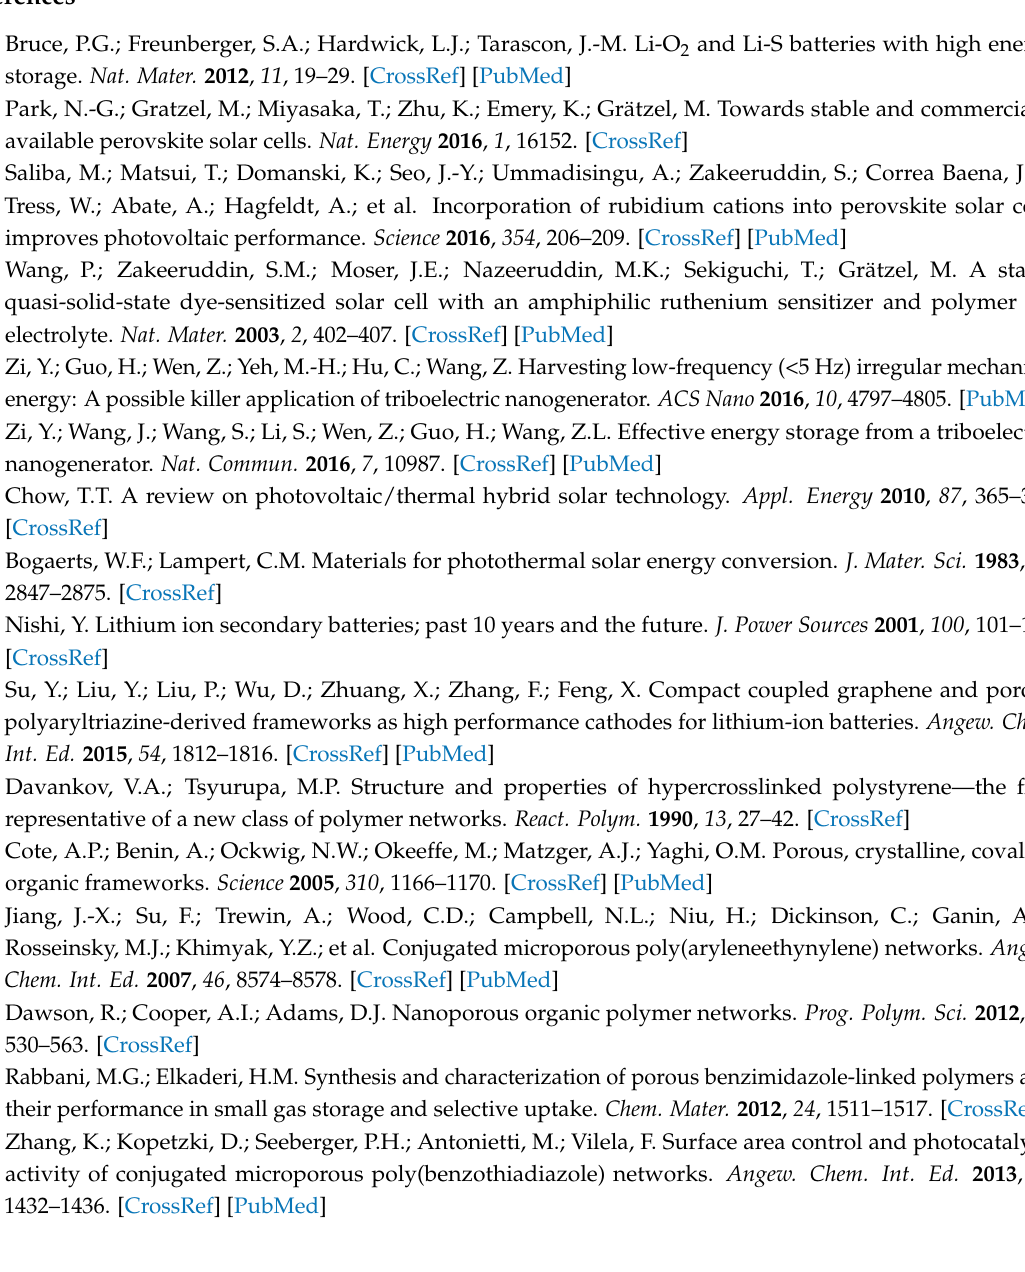
Figure S1. A schematic showing the structure and formation process of CTF-1; Figure S2: XRD patterns of CTF composites with different carbon materials. (a) CTF-CS, (b) CTF-CNT; and (c) CTF-GA; Figure S3. Pore size distribution of CTF and different CTF composites calculated from QSDFT; Figure S4: An SEM image of GA showing the macroporous nature; Figure S5: The FT-IR spectra and XRD pattern of CTF-rGO-400-600 proving the formation of the polymeric framework; Figure S6: Nyquist plots derived from AC impedance measurement